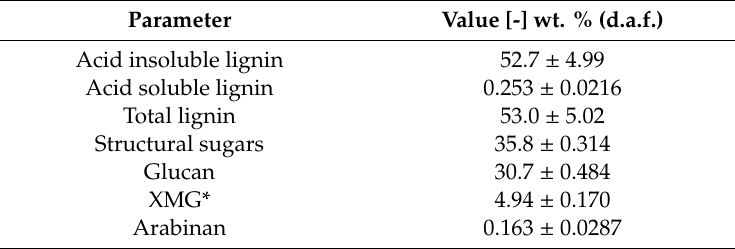
Table 1. Lignin and sugars content in